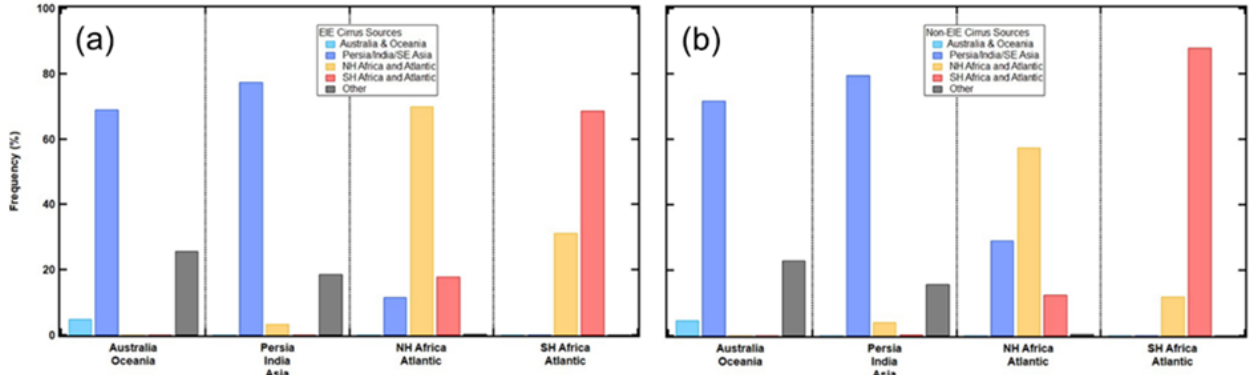
Figure 8. Similar to Fig. 5 but for (a) the percentage of CO anomalies under EIE ice cloud conditions and (b) non-EIEs shown by the source region of the CO (colored bars) within each geographical